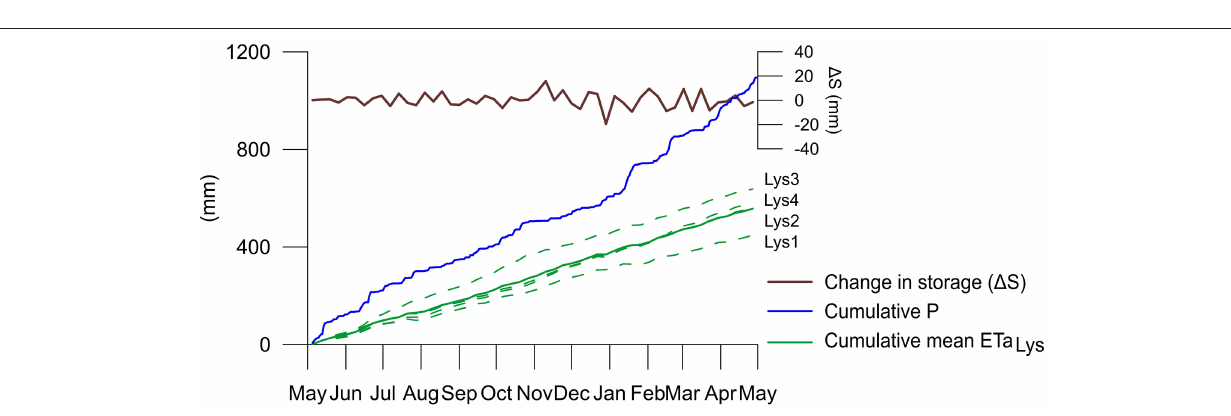
Frontiers in Earth Science |